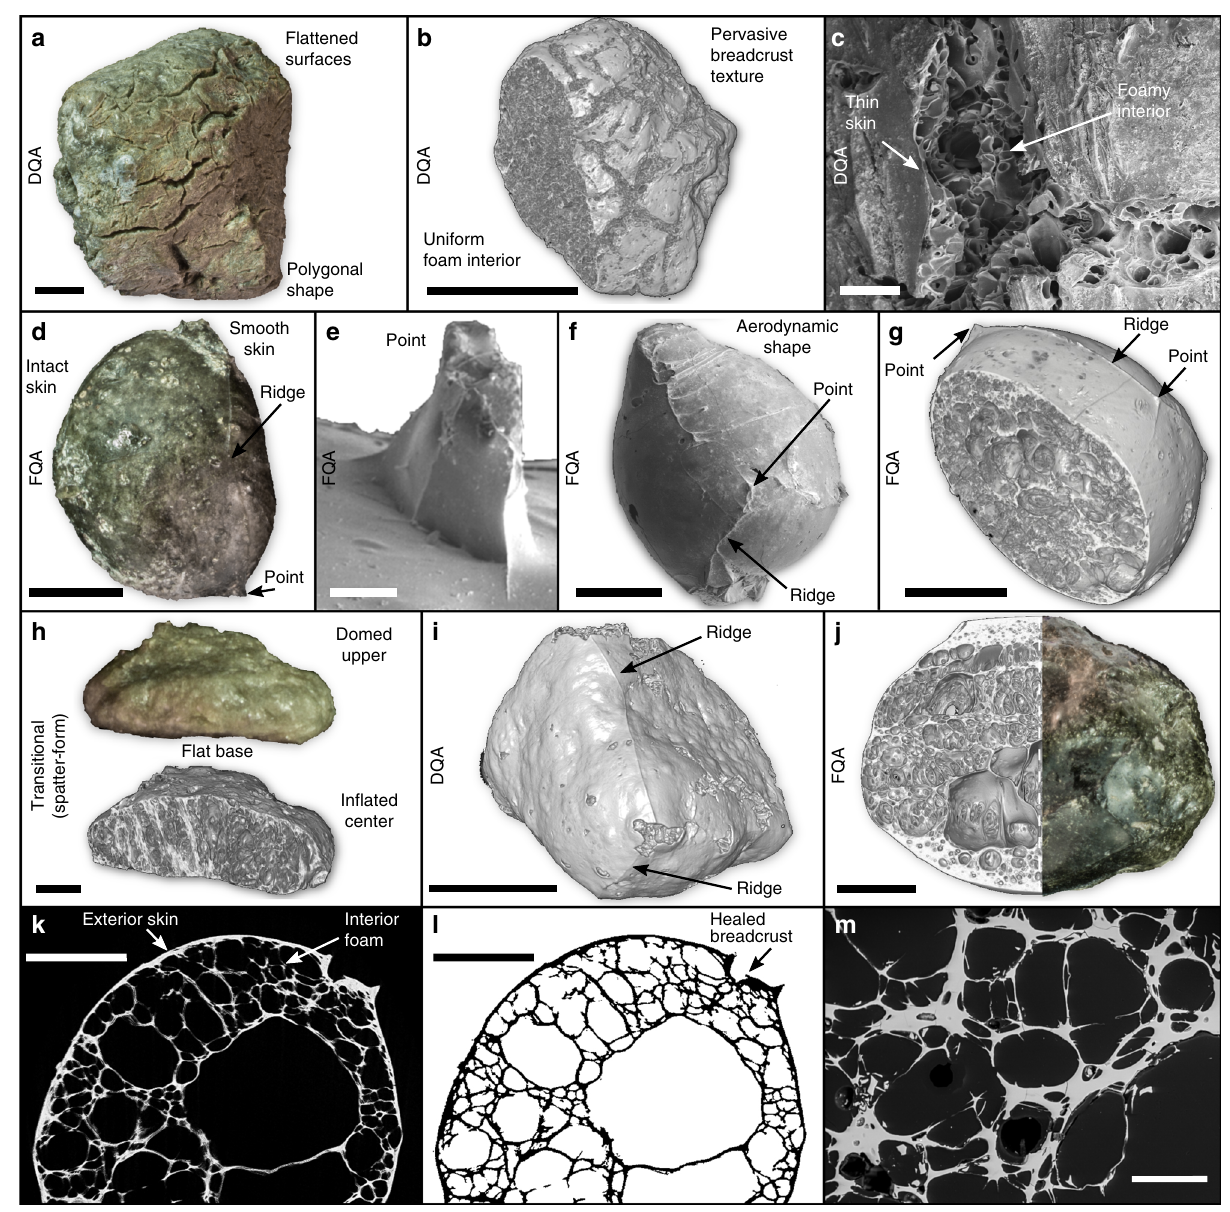
Fig. 2 Images displaying the primary features of pumiceous achneliths. a Photograph of a deposit quenched achnelith (DQA) (scalebar = 5 mm). b Seconday electron scanning electron microscope (SE SEM) image of a DQA (scalebar = 5 mm); c 3D rendering of an X-ray microtomographic (XCT) scan showing a DQA (scalebar = 200 μ m). d Photograph of a fl ight quenched achnelith (FQA) (scalebar = 5 mm), e SE SEM image of a point structure on an FQA (scalebar = 200 μ m); f SE SEM image of an FQA; g 3D rendering of XCT of an FQA (scalebar = 1 mm); h Photograph and 3D rendering of spatter- form lapillus, displaying aspects of FQA and DQA origins (i.e., deformed droplet) (scalebar = 1 mm); i 3D rendering of DQA showing remnant